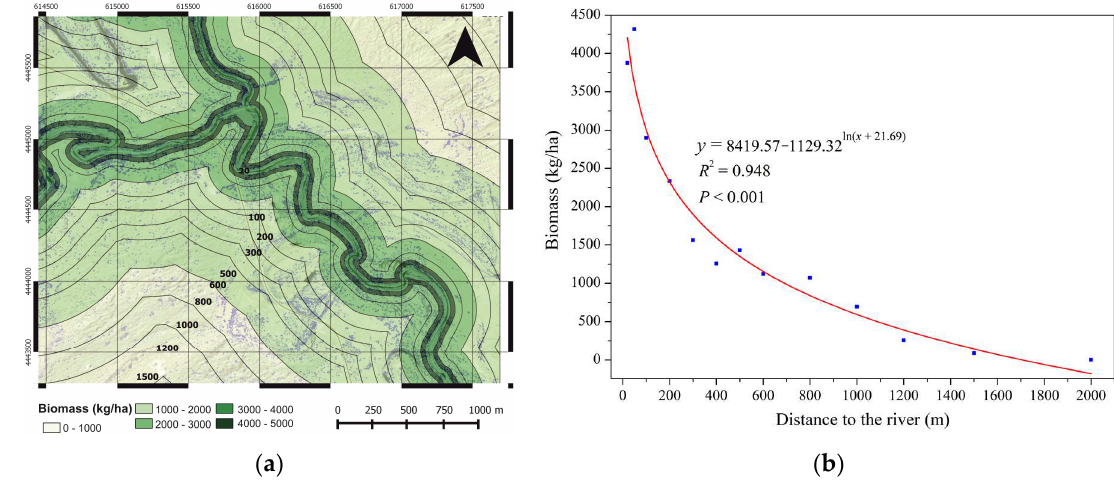
Figure 8. Biomass distribution pattern of P. euphratica along a gradient of water stress. ( a ) Biomass estimation in different buffer zones from the river; and ( b ) the relationship between biomass and distance from the river.